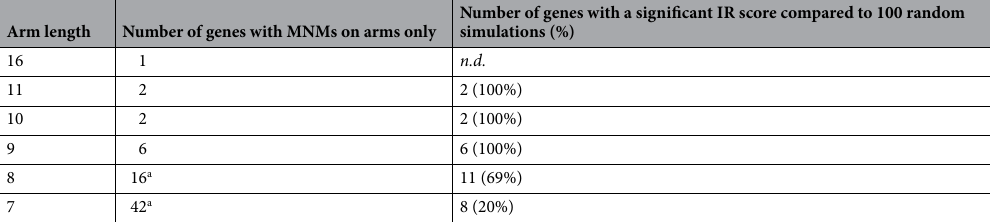
Table 1. Number of genes that include IRs with an arm length of ≥ 7 bp and are associated with multinucleotide mutations. a One gene had multinucleotide mutations ( MNMs) in both inverted repeats (IRs), which were 7 bp and 8 bp long. n.d. not